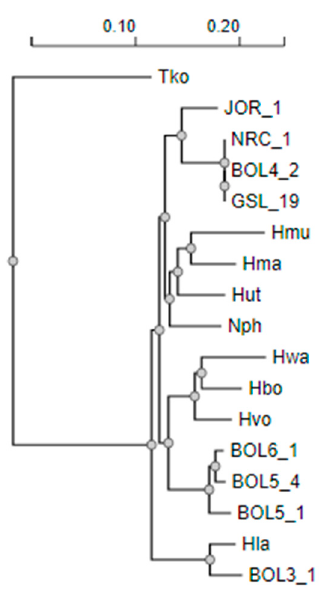
Figure 2. Phylogenetic NJ-tree of 16S rRNA from Haloarchaea. Laboratory models Halobacterium